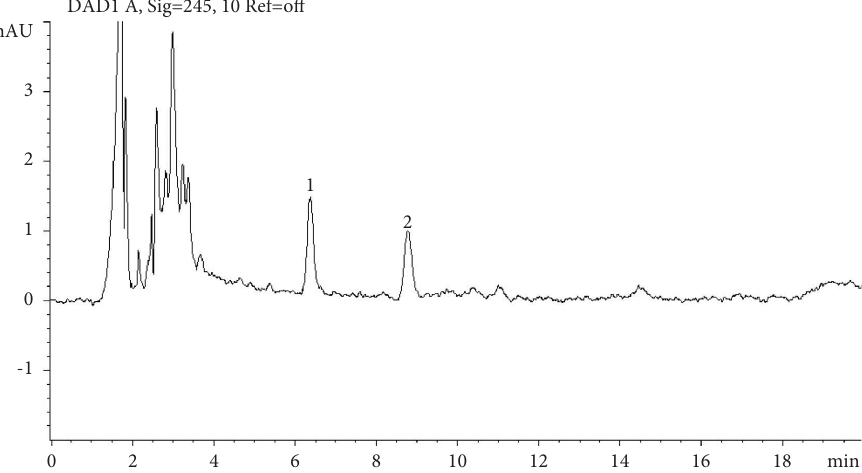
Figure 4: Chromatogram of a positive sample. Number 1 indicates doramectin peak (RT 6.372) and number 2 indicates ivermectin peak (RT 8.782). Table 1: Summary of uncertainty parameters.